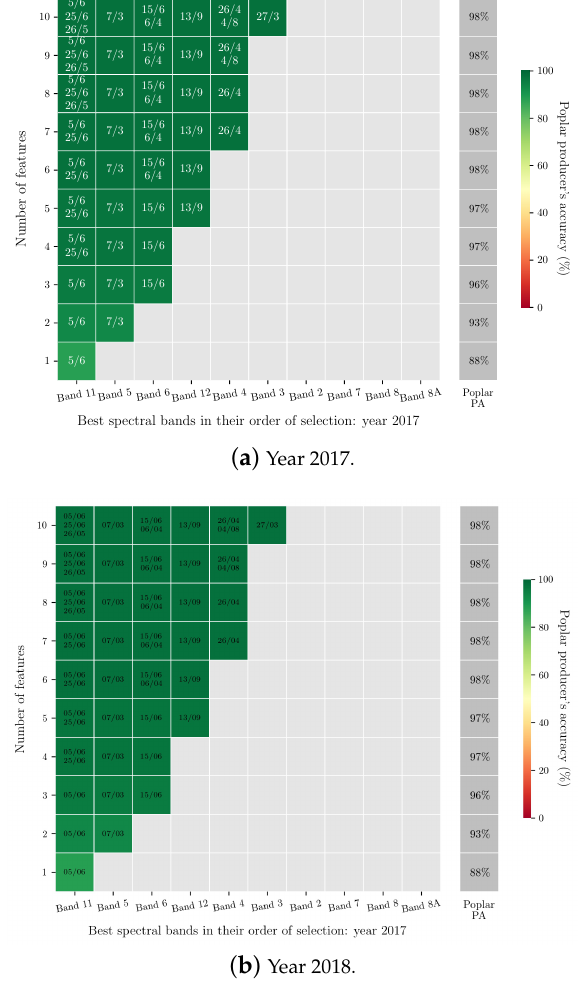
Figure 5. Average poplar PA as a function of the number of features selected with SFFS in the multi-band configuration: in ( a ), multi-band SFFS results in 2017; in ( b ), multi-band SFFS results in 2018. The y-axis represents the number of features, from 1 to a maximum of 10, and the corresponding spectral bands are listed in the x-axis in their order of appearance. The colours on the red-yellow- green scheme palette reflect the poplar’s PA values, also displayed in front of each number of features (grey cells on the right). The dates of the selected bands are given inside the cells. If a cell contains more than one date, it implies that the band was selected several times on different dates. Empty cells in light grey indicate that the band in the x-axis was not selected for the given number of features on the